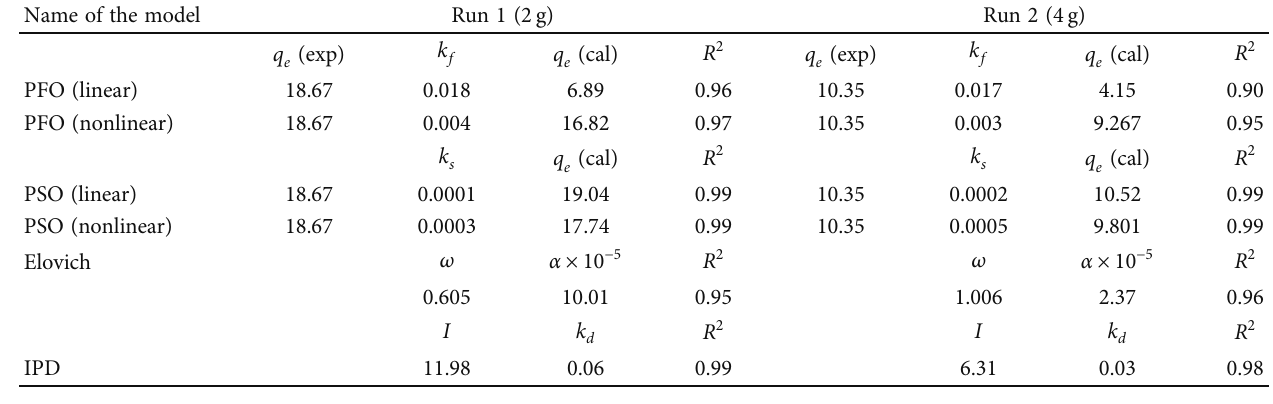
Table 9: Kinetic model parameters for the adsorption of Congo red dye on breadfruit leaves biochar. Name of the model